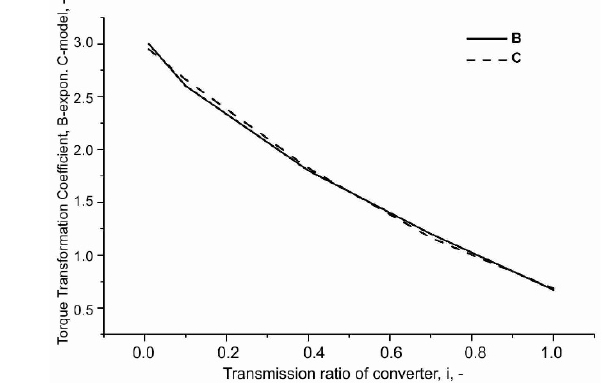
Figure 6 – Torque Transformation Coefficient Рис . 6 – Коэффициент трансформации крутящего момента Слика 6 – Коефицијент трансформације обртног